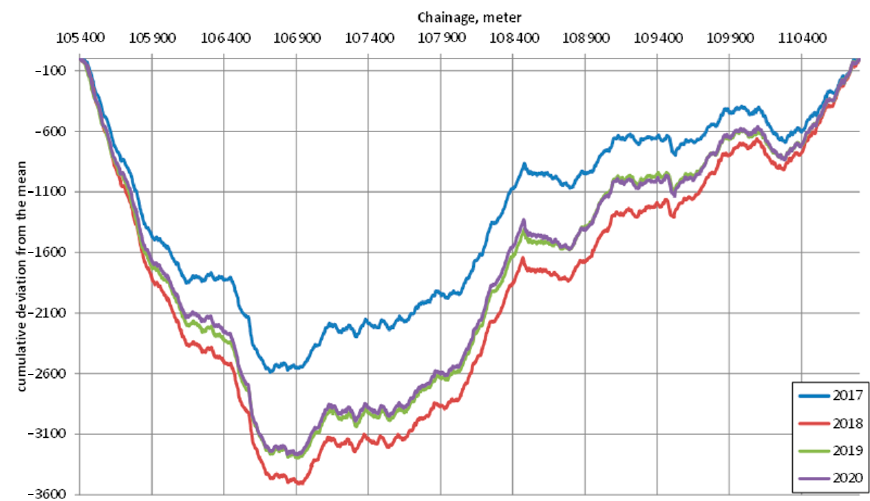
Figure 5. Cumulative deviation from the mean (section No. 3).